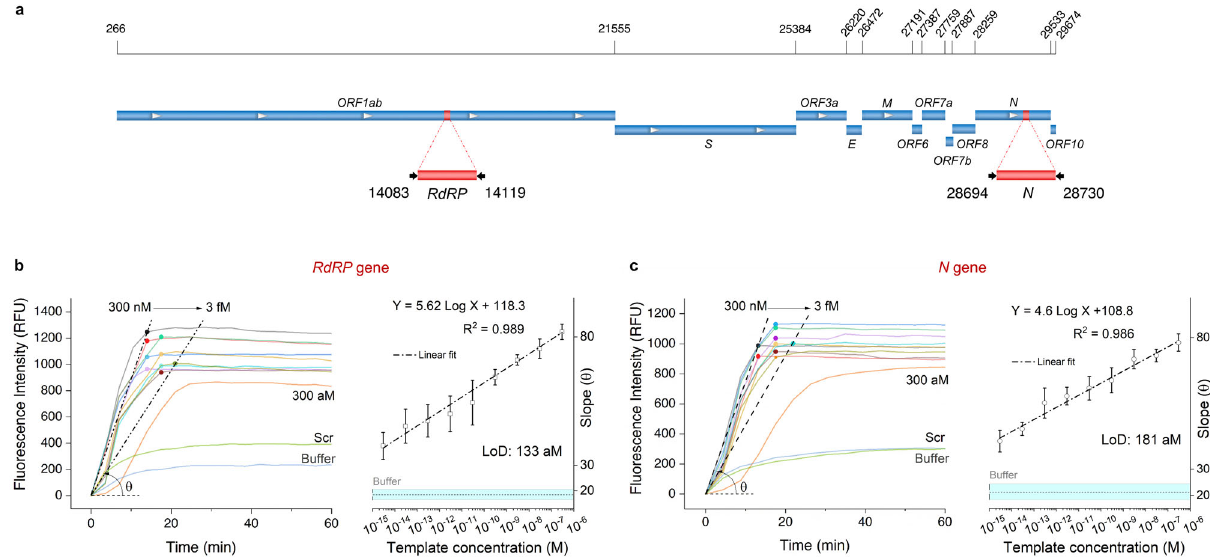
Fig. 3 Assay performance on the Template. a Genome map of the SARS-CoV-2 isolate Wuhan-Hu-1, depicting two studied regions of RdRP and N genes and their corresponding nucleotide positions (red bars). Typical curves illustrating the kinetics of the fl uorescence signal of the assay, designed for b , RdRP gene and c , N gene, over time for serial dilutions of the Template from 300 nM down to 300 aM in TES buffer (pH 7.8). The linear regression plots from 300 nM down to 3 fM are shown for each corresponding curves. Three independent experiments were run ( n = 3). The assay comprising M1 and M2 probes was launched at the constant temperature of 42 °C while the fl uorescence intensity of 6-FAM was recording each 3.5 min. RFU and Scr denote for relative fl uorescence unit and scrambled DNA sequence, respectively. The Slope values ( Ɵ ) were calculated based on the value of saturated fl uorescence intensity recorded for each graph (indicated as fi lled circles) dividing by the corresponding time intervals. Error bars represent mean ± SD. The solid boxes represent mean values for buffer ± SD. Source data for ( b , c ) are provided as a source data fi